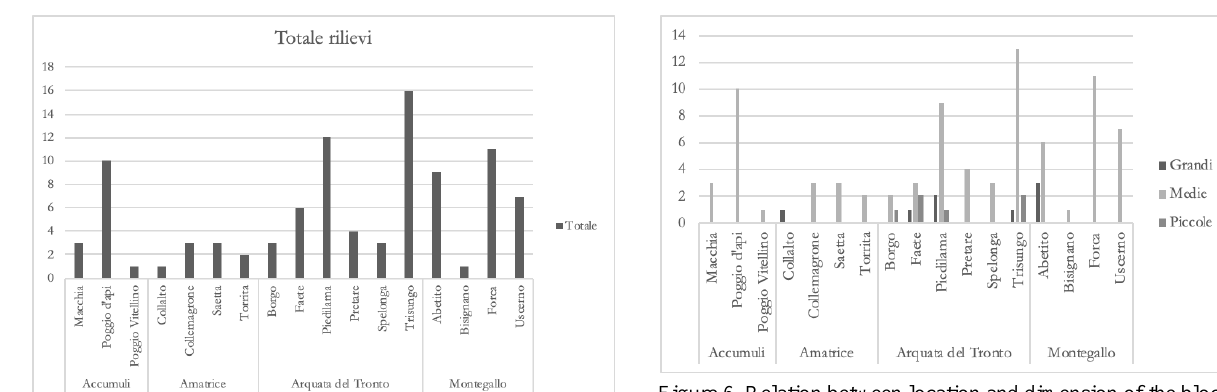
Figure 6. Relation between location and dimension of the block.